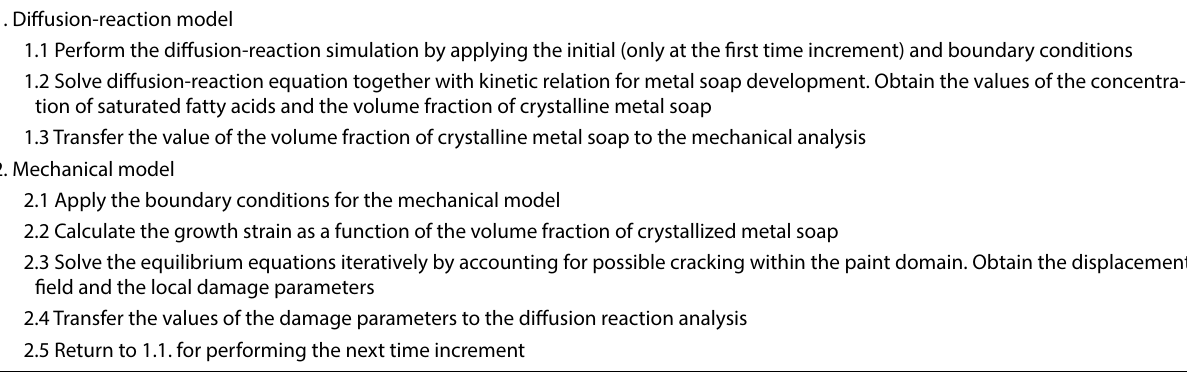
Fig. 2 Model of a paint layer containing a metal soap crys- tal. The geometry is discretized by continuum finite elements, which model the bulk behav- iour of the paint and the metal soap. The cohesive elements placed in between the con- tinuum elements (as schemati- cally indicated by the dashed lines in the inset) simulate possible crack